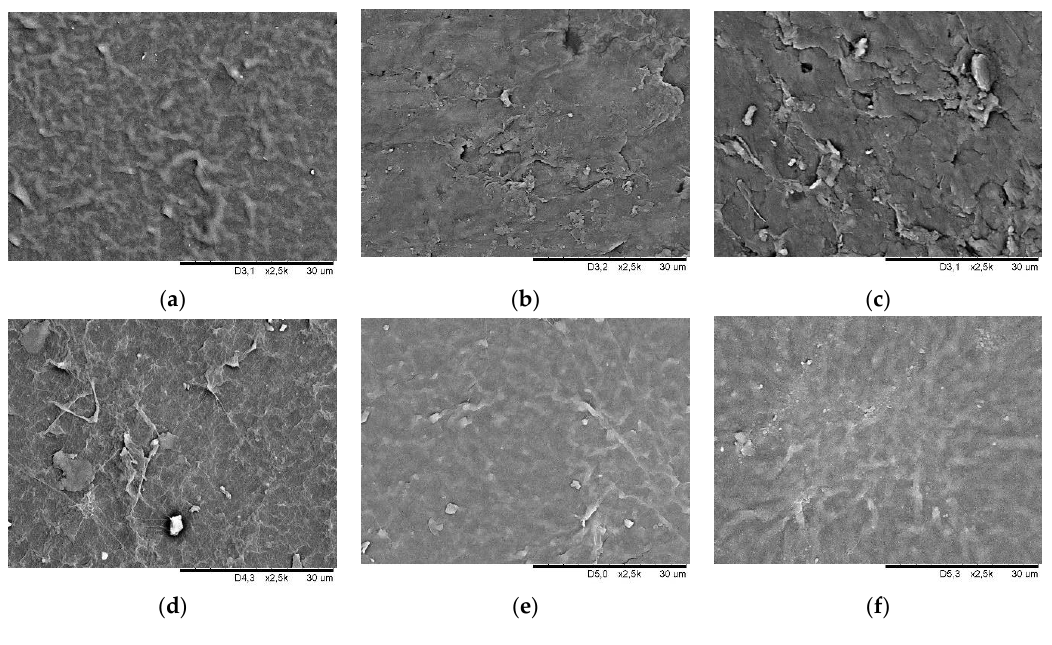
Figure 7. Surface morphology SEM image of butyl rubber smooth samples ( a ) chemically non-modified, ( b ) plasma-modified in the air, ( c ) plasma-modified in argon, ( d ) chemically modified, ( e ) chemically and plasma-modified in the air, and ( f ) chemically and plasma-modified in argon.